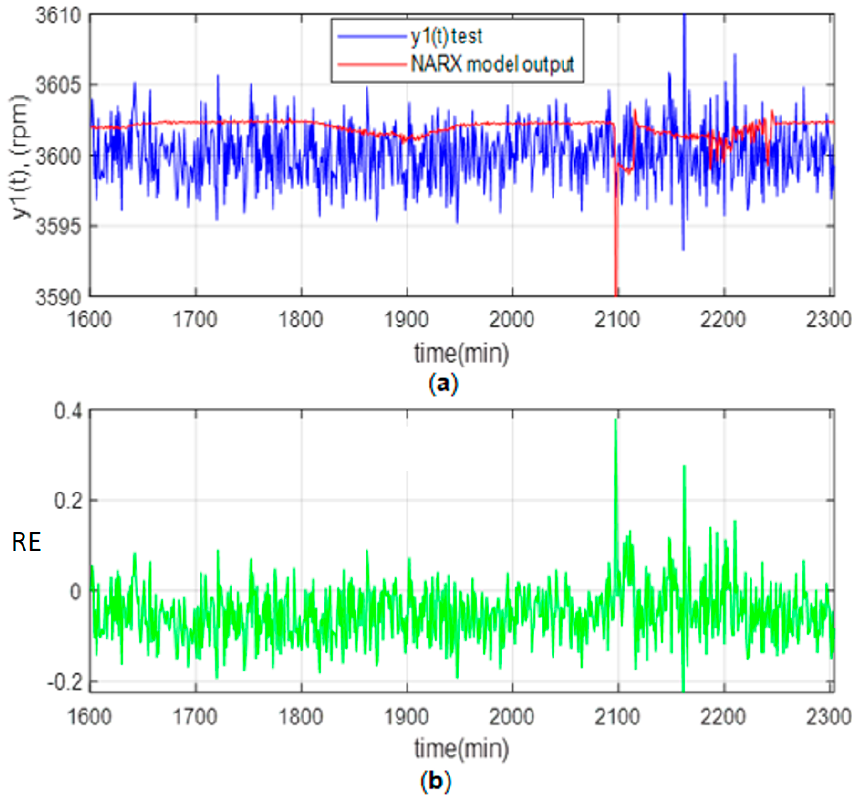
Figure 13. Test results: ( a ) Angular velocity; ( b ) Relative Error (RE).